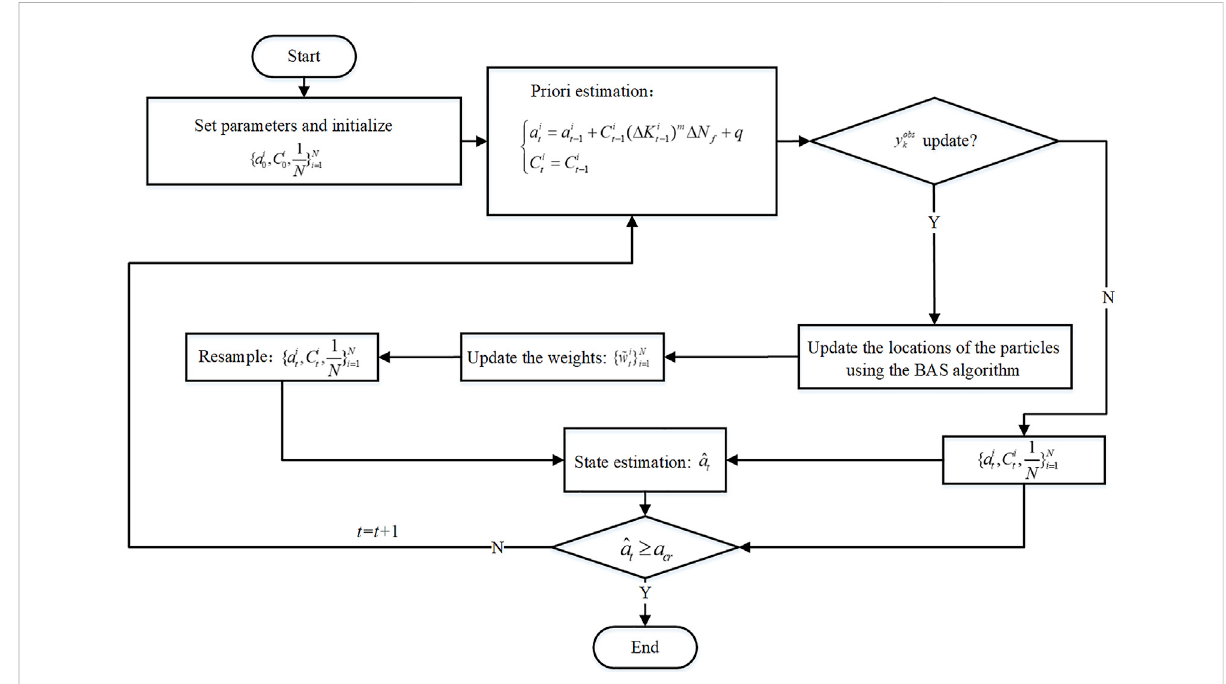
FIGURE 2 Fatigue crack growth prediction based on IBAS-PF algorithm.